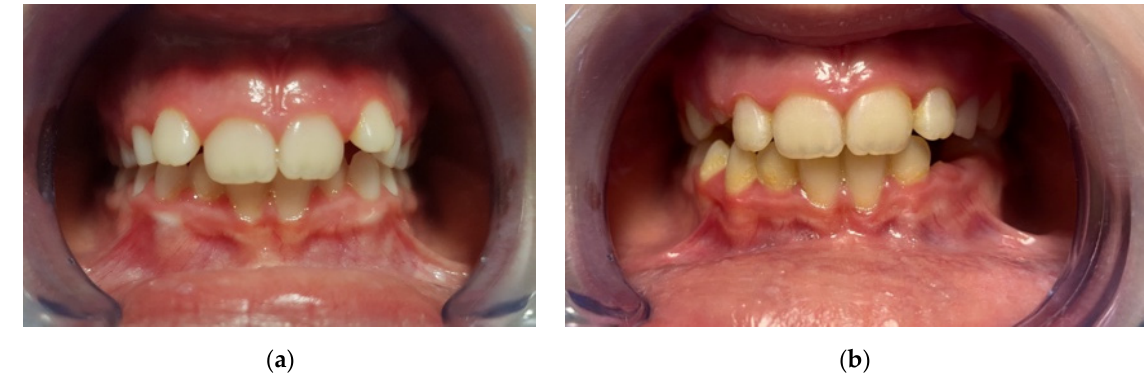
Figure 3. Intraoral frontal photographs of one of the included subjects treated with AMCOP device. ( a ) pre-treatment (T0), ( b ) post-treatment (T1).